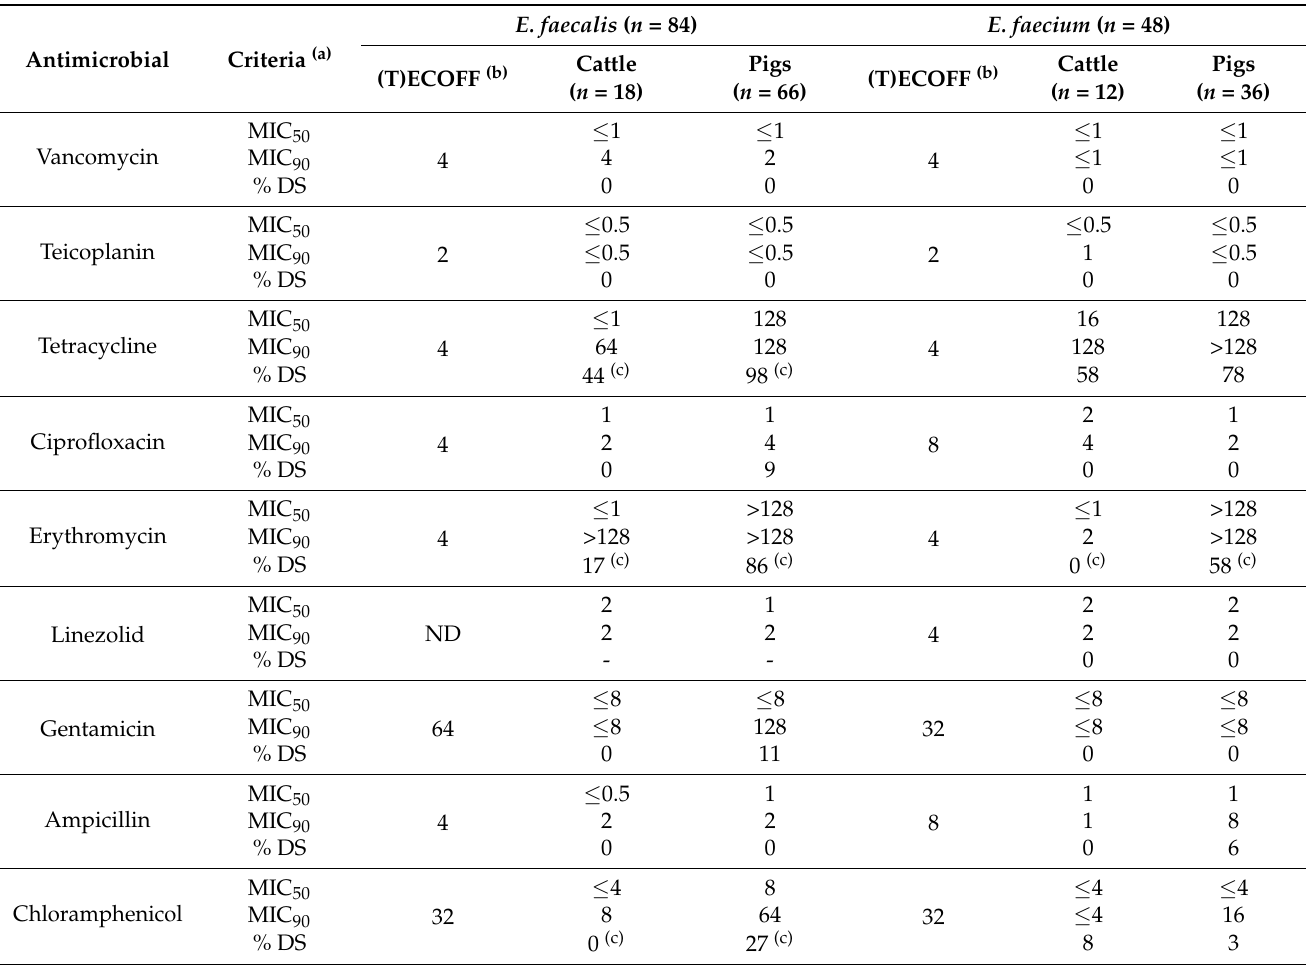
Table 1. Antimicrobial susceptibility of E. faecalis and E. faecium isolates ( n = 132) using the agar dilution